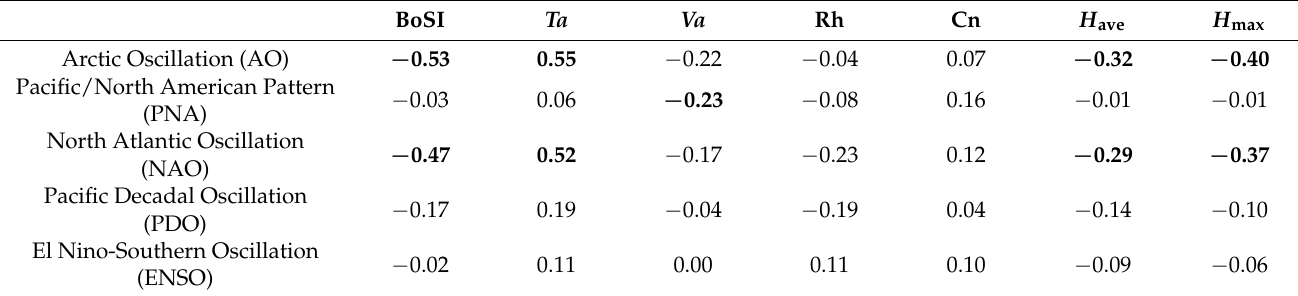
Table 7. Correlation